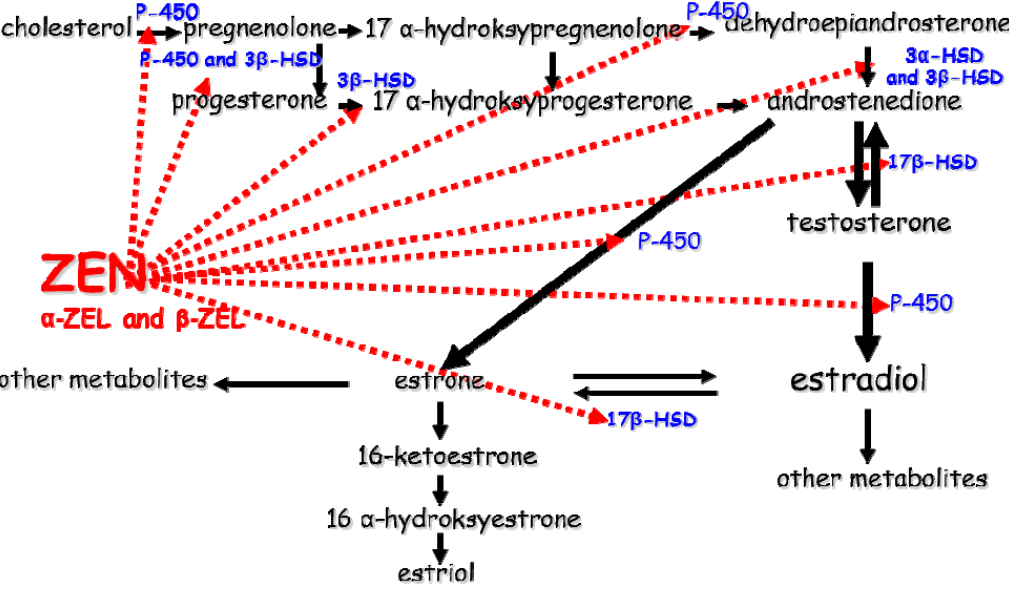
Figure 1. Sites where ZEN and its metabolites influence the activity of selected enzymes during steroidogenesis. ZEN, zearalenone; α -ZEL, α -zearalenol; β -ZEL, β -zearalenol; 3 α -HSD, 3 α -hydroxysteroid dehydrogenase; 3 β -HSD, 3 β -hydroxysteroid dehydrogenase; 17 β -HSD, 17 β -hydroxysteroid dehydrogenase; P-450, cytochrome